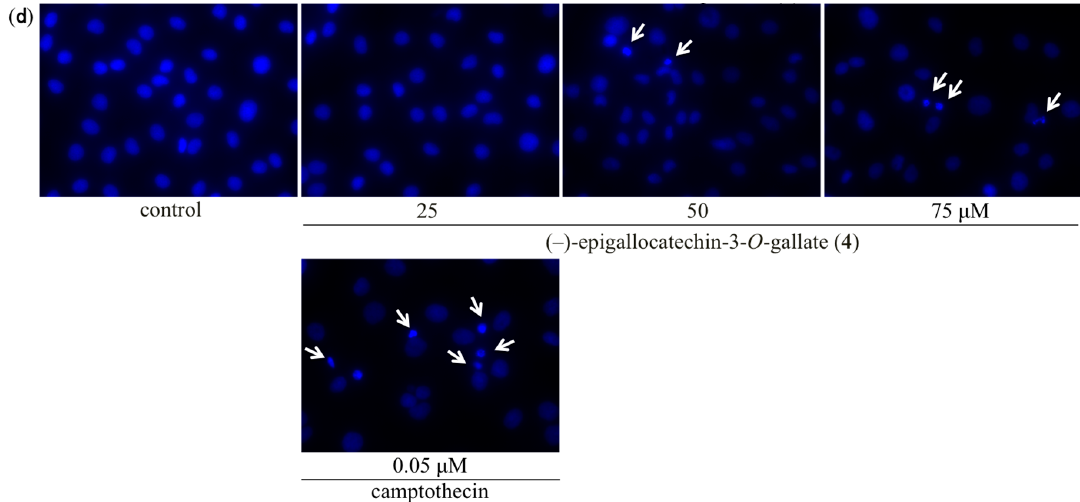
Figure 4. Morphological analysis of HSC-2 cells treated with 1 – 4 and camptothecin. Morphology of representative fields of HSC-2 cells stained with 4’,6-diamidino-2-phenylindole dihydrochloride (DAPI) after treatment with ( a ) 5, 7.5, and 10 µM of 1 ; ( b ) 10, 15, and 17.5 µM of 2 ; ( c ) 2.5, 5, and 7.5 µM of 3 ; ( d ) 25, 50, and 75 µM of 4 and 0.05 µM of camptothecin for 48 h; the cells indicated by arrows represent fragmented and condensed nuclear chromatins; commercial camptothecin was purchased from Wako Pure Chemical Industries, Ltd. (Osaka, Japan).